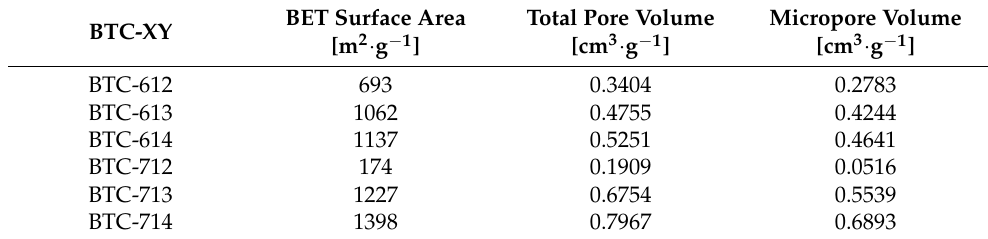
Table 1. BET surface area and pore volume of the BTCs.